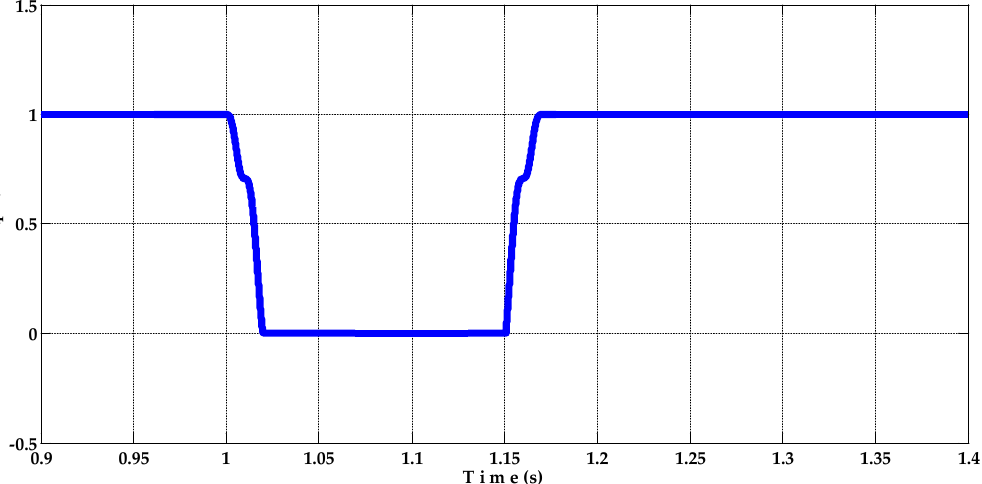
Figure 5. Per unit rms terminal voltage (Va) of the studied wind farm main coupling point under symmetrical fault occurrence.